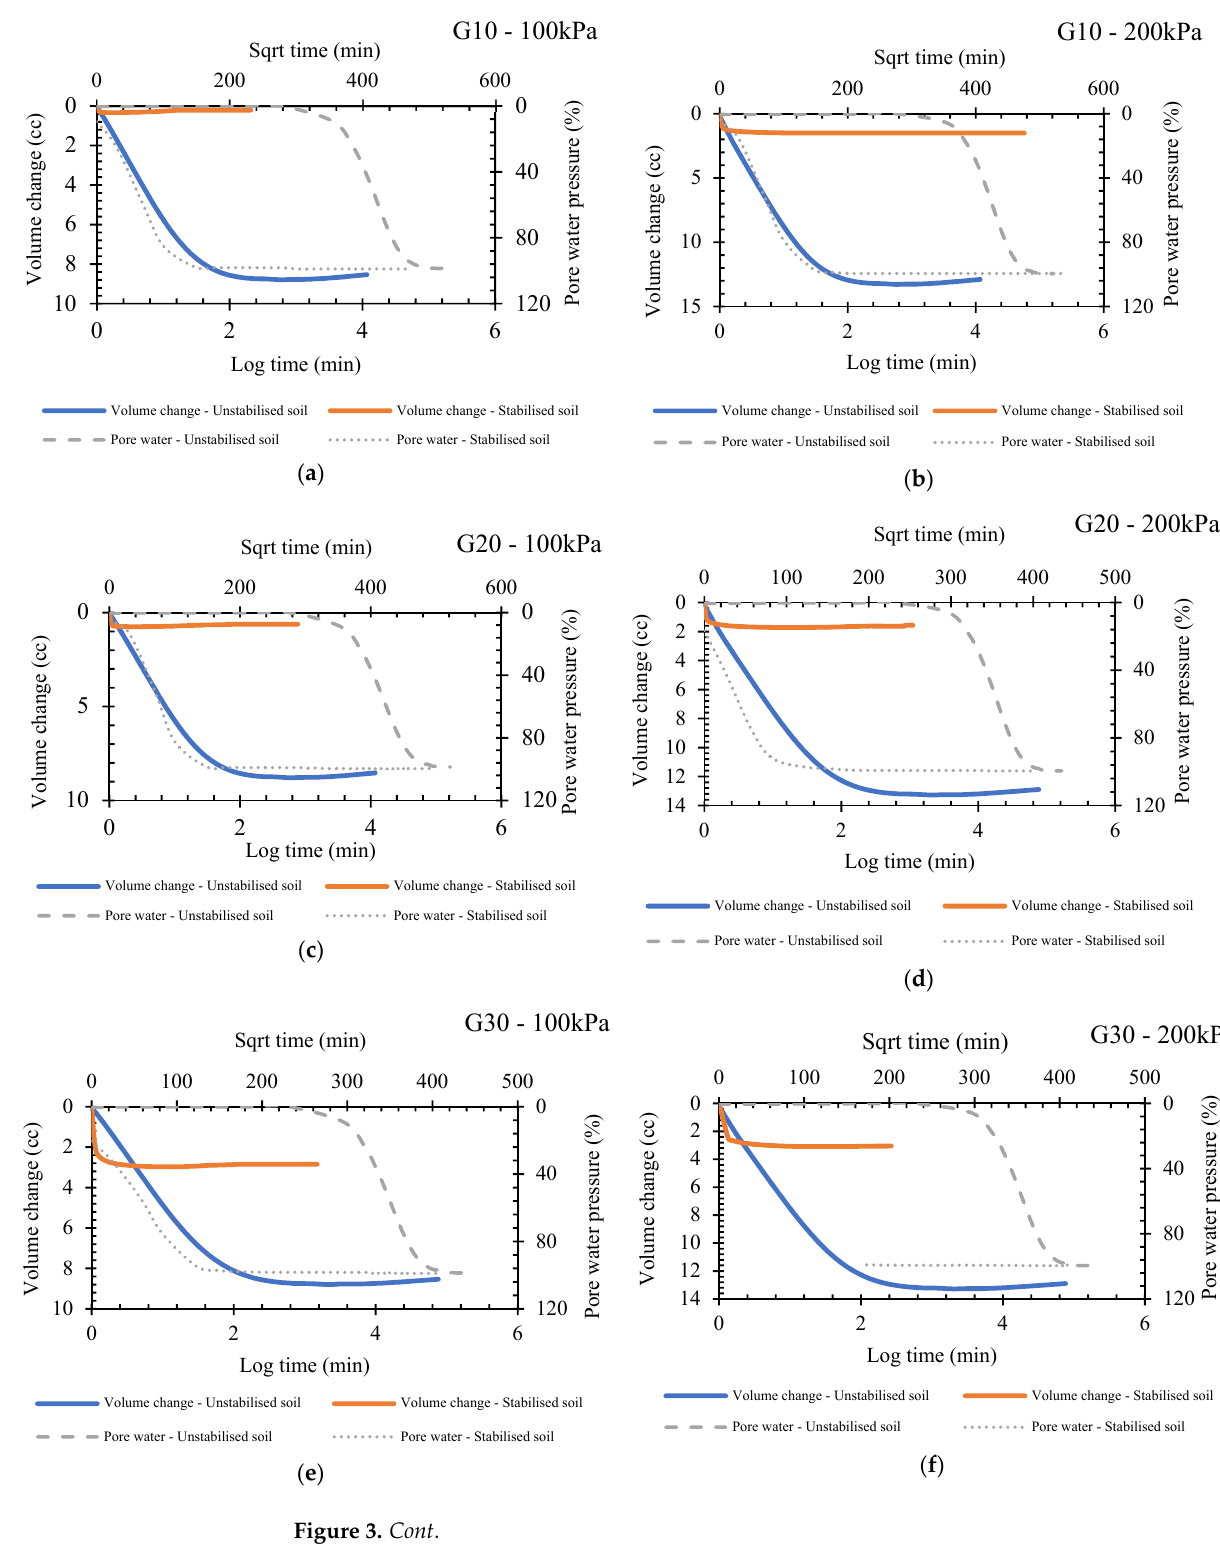
( j ) Figure 3. Volumetric and pore pressure responses: ( a ) 10% gypsum content and constant effective pressure of 100 kPa; ( b ) 10% gypsum content and constant effective pressure of 200 kPa; ( c ) 20% gypsum content and constant effective pressure of 100 kPa; ( d ) 20% gypsum content and constant effective pressure of 200 kPa; ( e ) 30% gypsum content and constant effective pressure of 100 kPa; ( f ) 30% gypsum content and constant effective pressure of 200 kPa; ( g ) consolidation of unstabilised soil under constant effective pressure of 100 kPa; ( h ) consolidation of unstabilised soil under